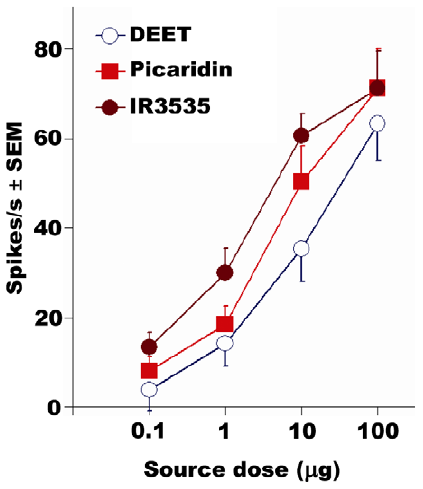
Figure 5. All three insect repellents induce dose-dependent excitatory responses in the pb1A ORN. Hexane (control) responses were subtracted. ( N =7). Error bars are standard error of the mean (SEM).